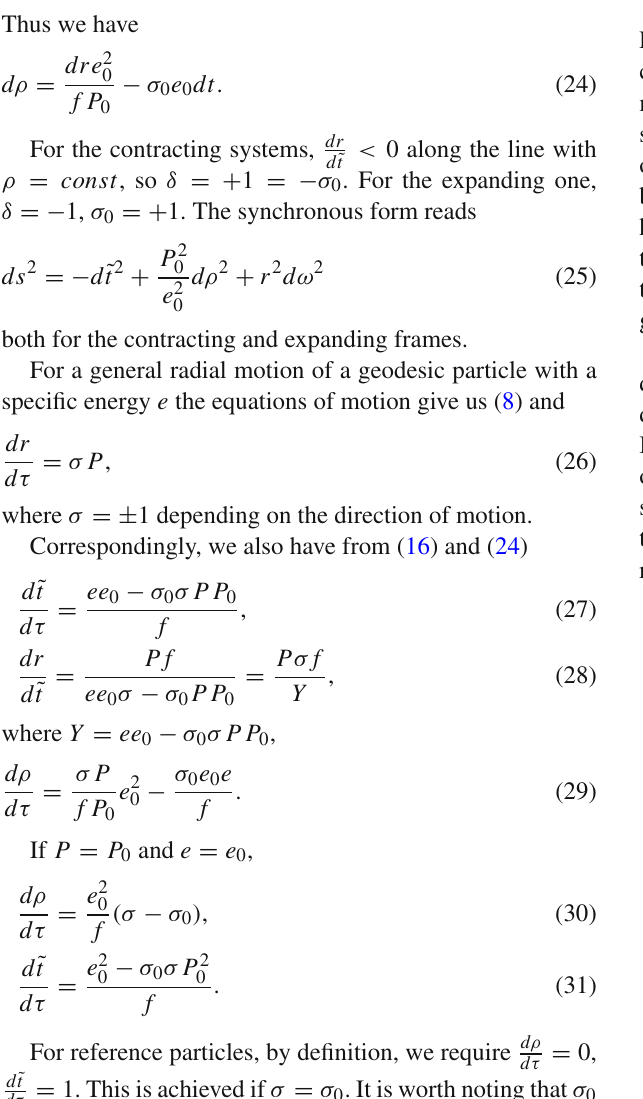
Fig. 1 The Kruskal diagram for the Schwarzschild